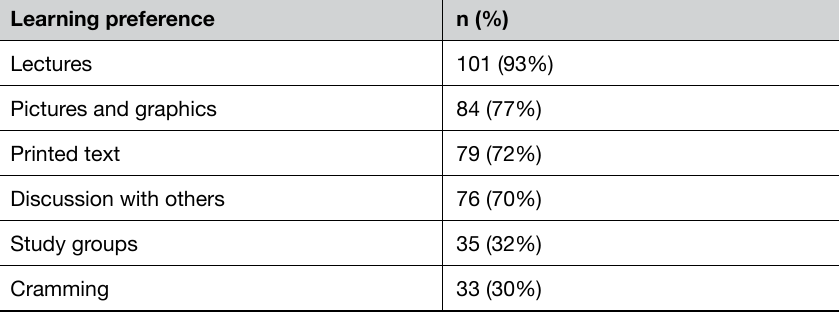
Table 4: Participants’ personal learning preferences